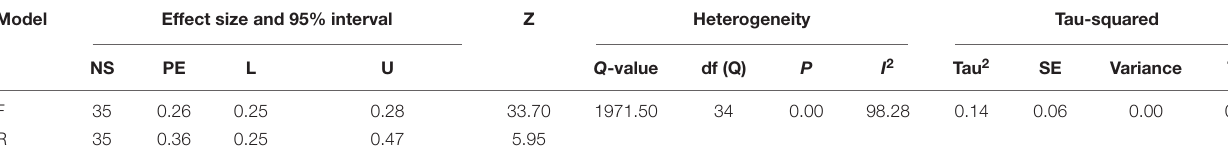
TABLE 3 | Fixed effects and random effects meta-analysis.